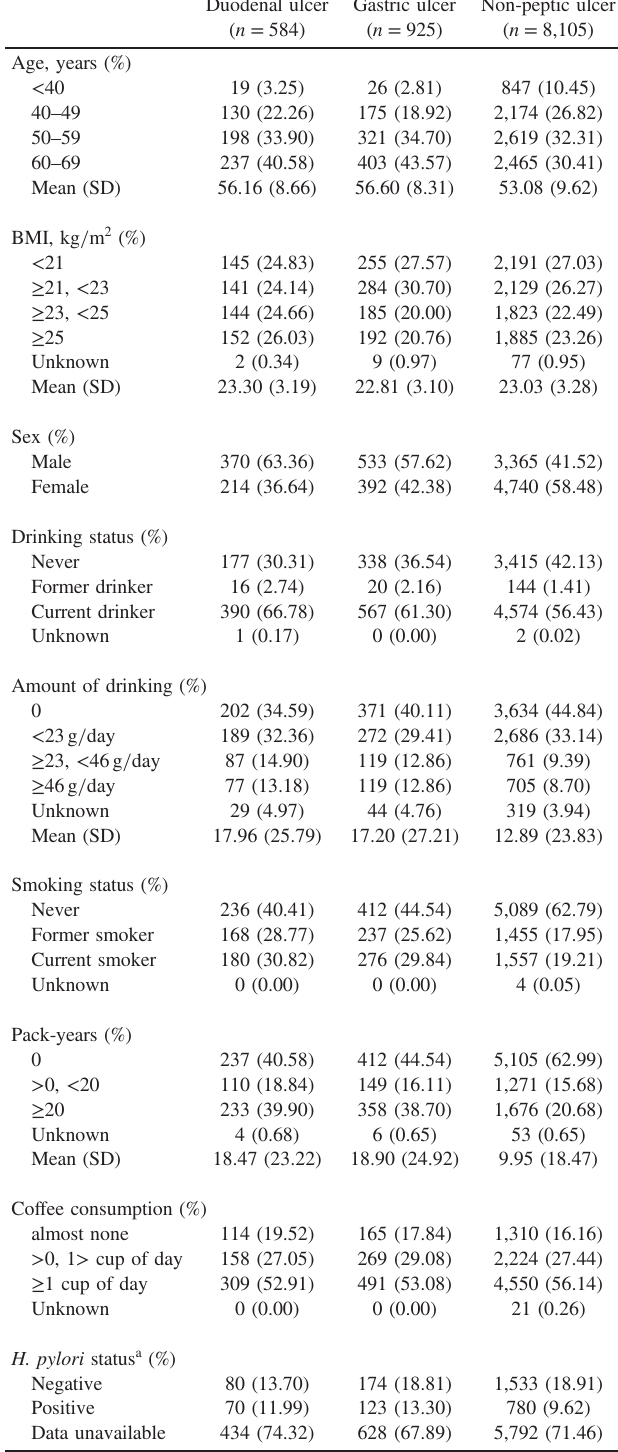
Table 1. Characteristics of the study subjects